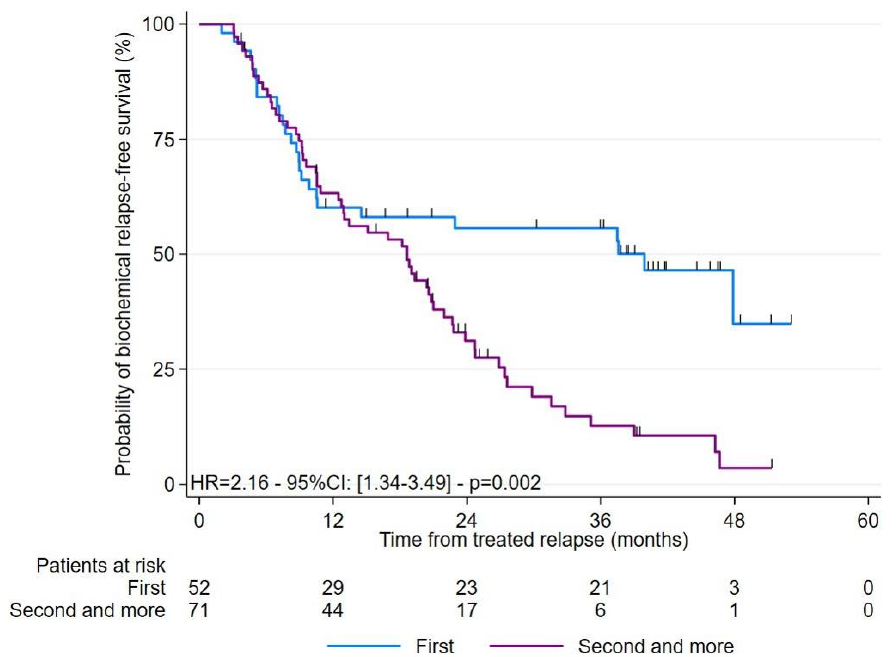
Figure 3. Kaplan-Meier curves for BR-FS according to patients with their 1st or (2nd–3rd–4th) BR